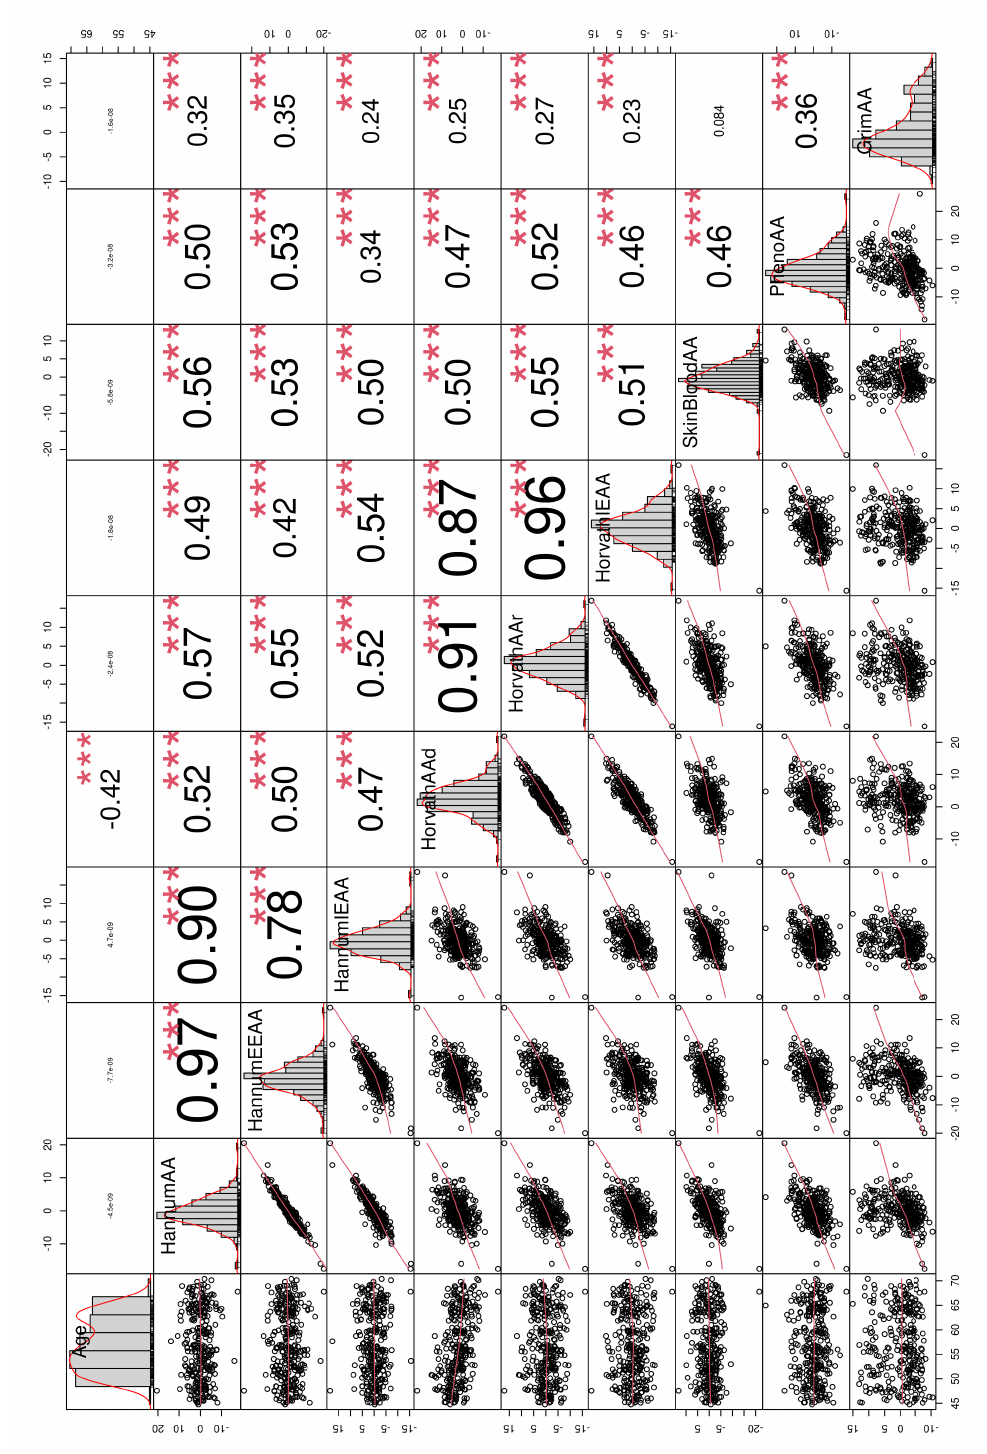
Figure A2. Correlation table for EAAs. Red asterisks correspond to the correlation test p -values as follows: *** for p <